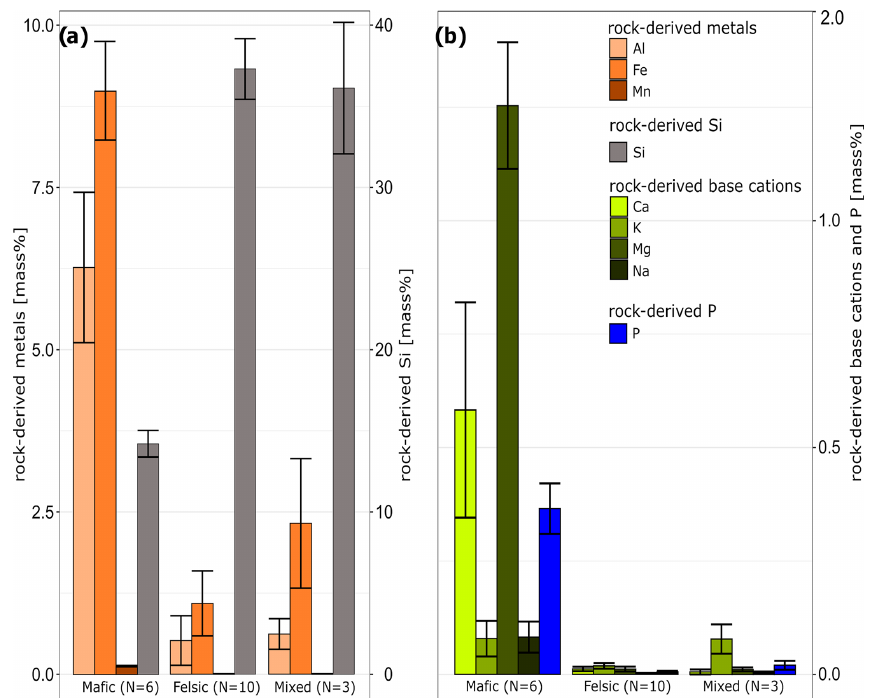
Figure 3. Chemical composition of unweathered rock samples representing the parent material for soil formation in three studied geo- chemical regions (mean ± standard error). Panel (a) shows the distribution and concentration of rock-derived aluminum (Al), iron (Fe), and manganese (Mn) and total silica content (Si). Panel (b) shows the distribution and concentration of rock-derived calcium (Ca), potassium (K), magnesium (Mg), sodium (Na), and phosphorus (P). Note the difference in scale on the y axis between panels (a) and (b) .